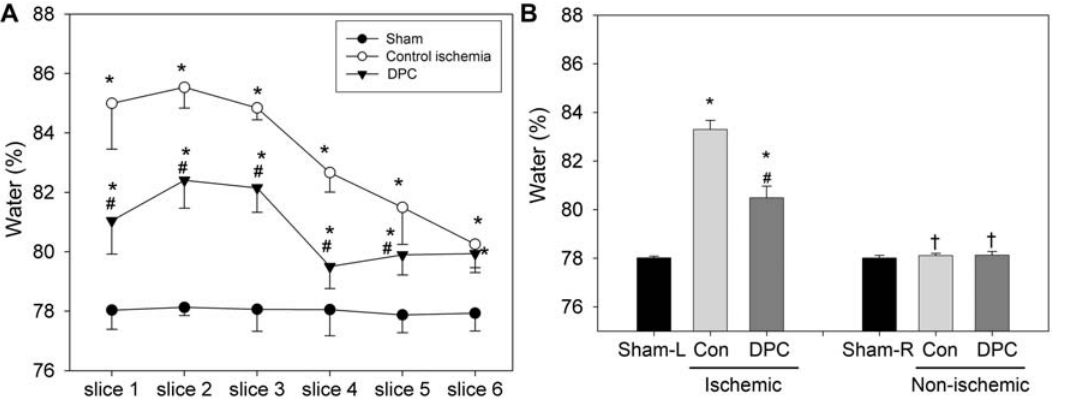
Figure 7. Delayed postconditioning (DPC) mitigated edema after stroke. Rat brains were harvested at 48 h after stroke for edema measurement. The rat brains were sectioned coronally at 2 mm intervals, generating a total of 6 blocks from rostral to caudal. A. Rostral to caudal slice water content. Water contents in all 6 slices are presented. * vs. sham, P , 0.001; # vs. control, P , 0.001. B. Mean water content from all slices of the ischemic and non-ischemic hemisphere from rats with sham surgery, control ischemia, and delayed postconditioning. The mean value from the 6 blocks of each hemisphere was calculated, and a mean value from all rats (n=6/group) is presented. DPC attenuated overall edema after stroke. Ischemic, ischemic hemisphere; non-ischemic, non-ischemic hemisphere; con, control ischemia. * vs. Sham-L, P , 0.05; # vs. con, P , 0.05; { vs. ischemic hemisphere, P , 0.05.